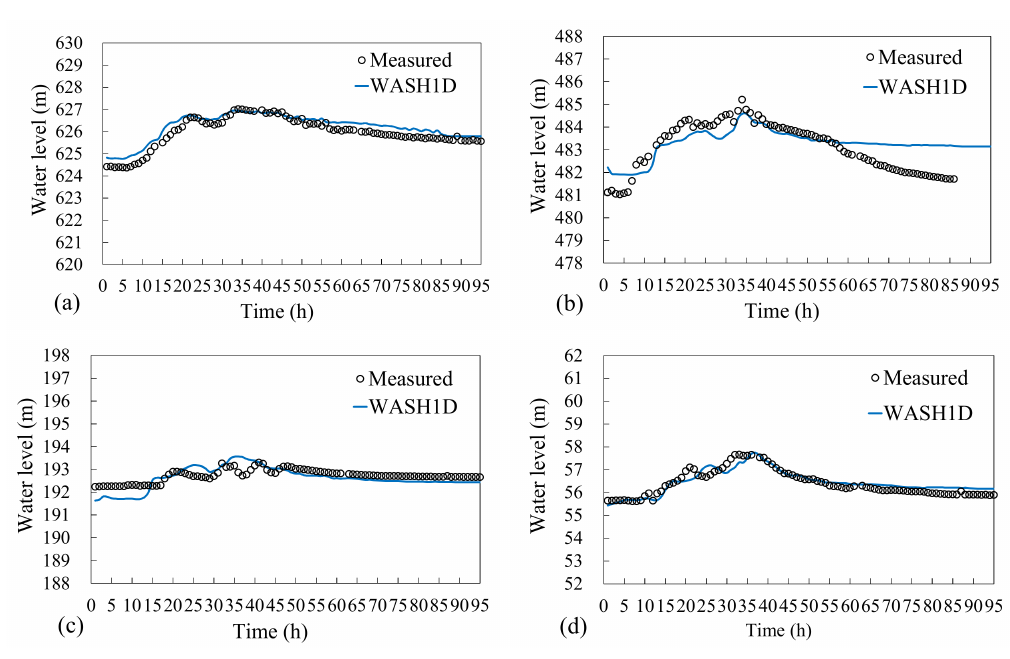
Figure 7. Comparisons of the measured and simulated water levels at ( a ) Xiangbi, ( b ) Shuangqi, ( c ) Yili, and ( d ) Dadaian gauging stations for Typhoon Saola (July 2012).